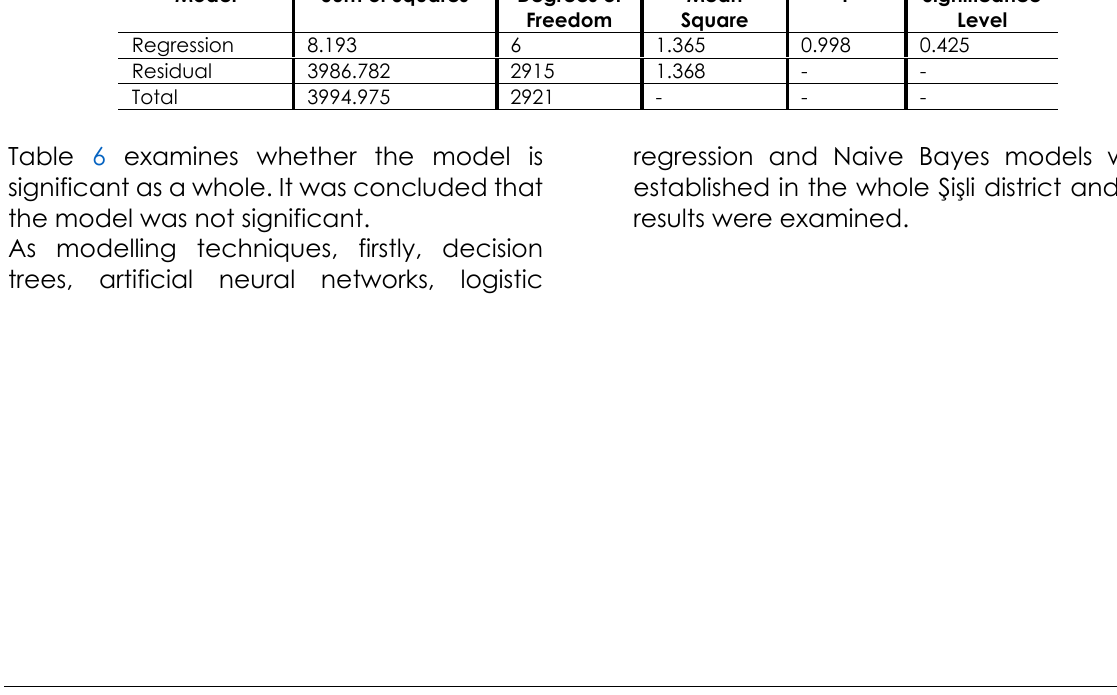
Table 6. Table of variance in the model established to determine whether there is a day effect on accidents.